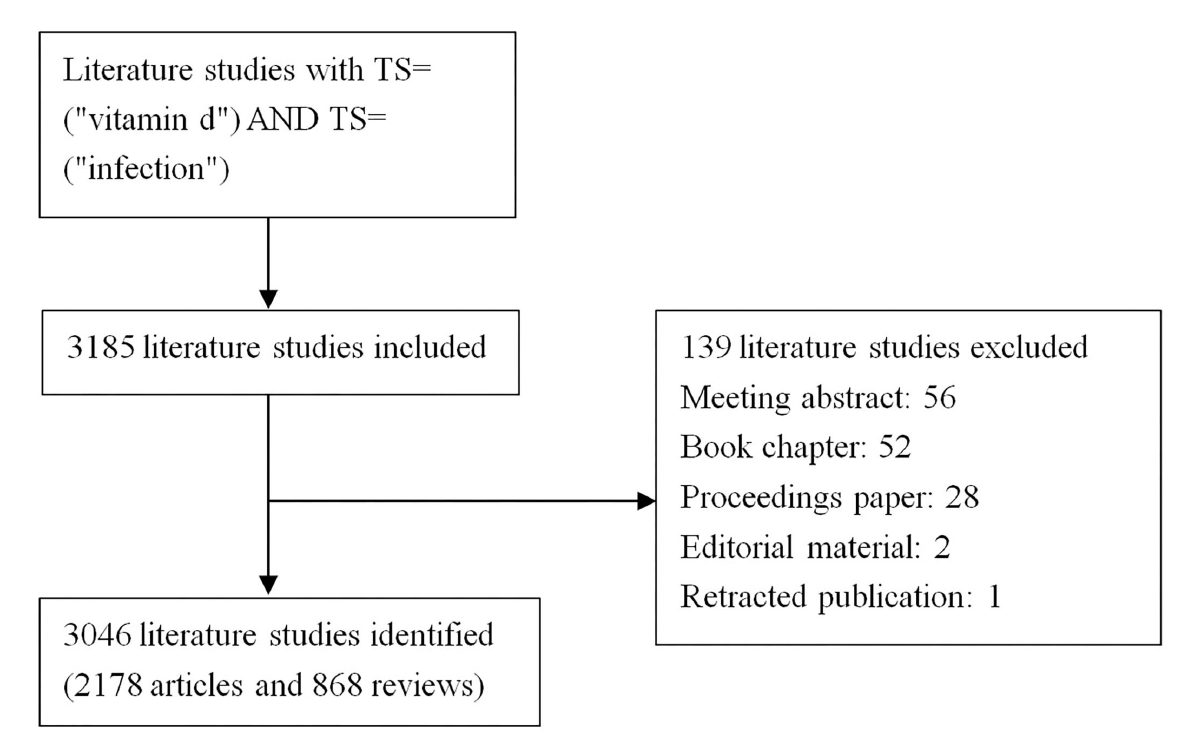
FIGURE1 Flowchart of literature screening. Data collection was done on a single day 17 April 2022. A total of 3,185 records from the Web of Science Core Collection (WoSCC) database were retrieved. Then, 139 data were excluded including meeting abstracts, book chapters, proceeding papers, editorial materials, and retracted publications. Finally, 3,046 pieces of data were obtained, including 2,178 articles and 868 reviews. Data were imported into the CiteSpace software (version 5.8.R3) for further